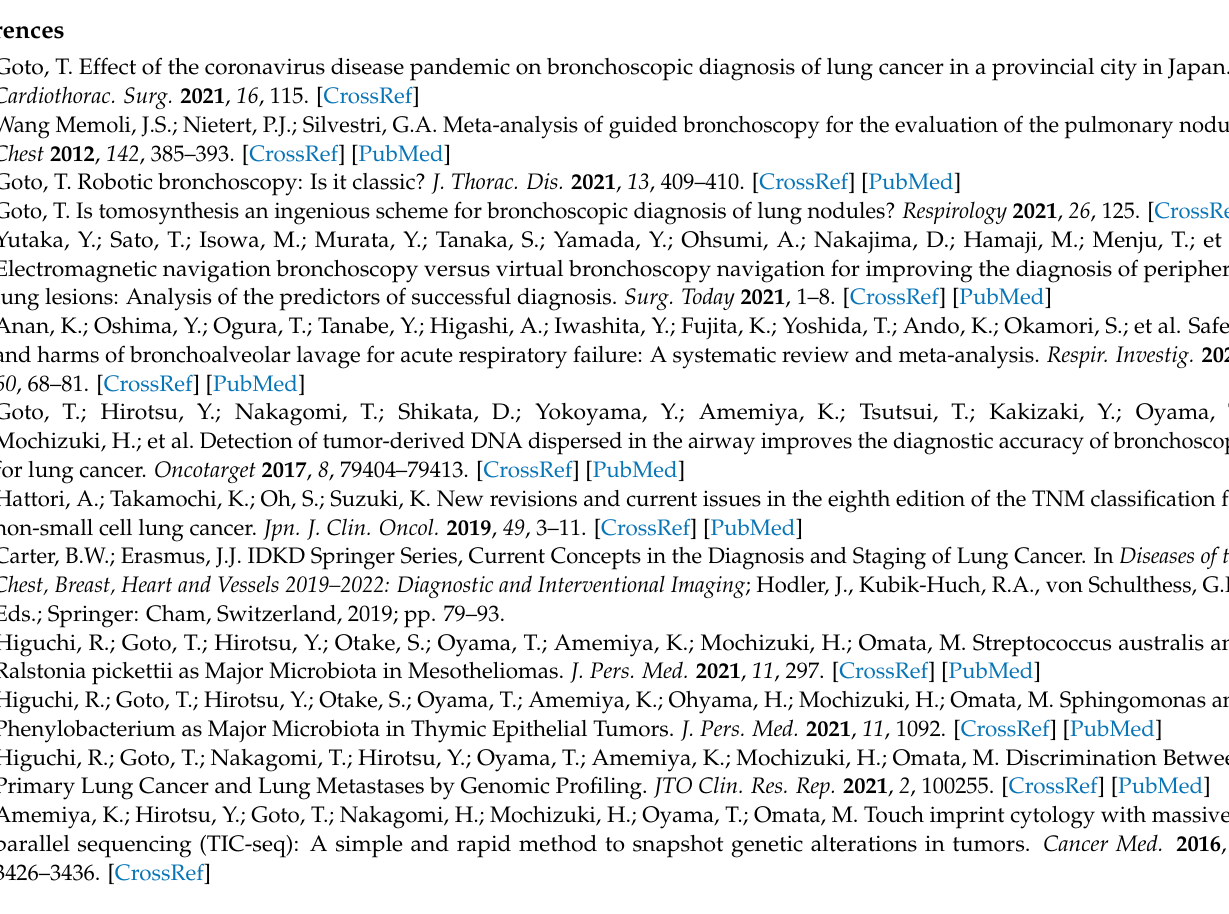
characteristics, Table S3: Sequencing data in each sample, Table S4: Comparison of allele fraction of mutated genes in bronchoalveolar lavage (BAL)